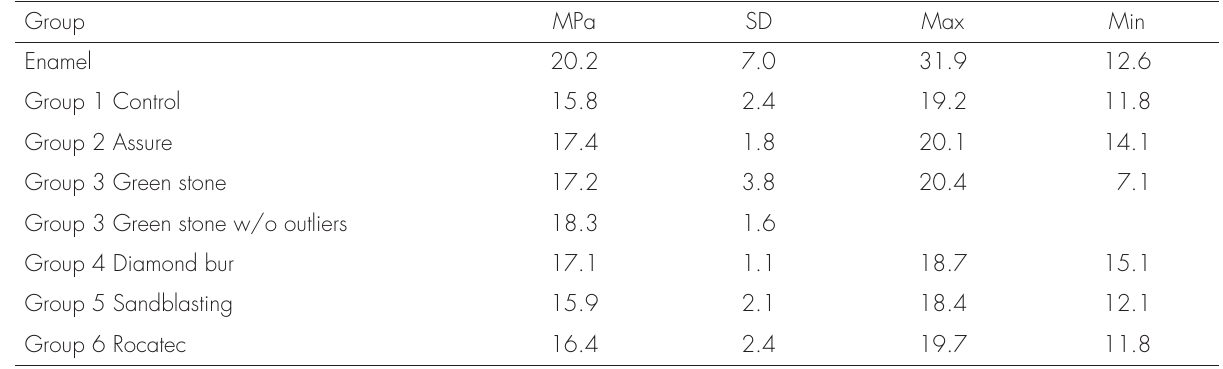
Table I. Mean SBS values for all